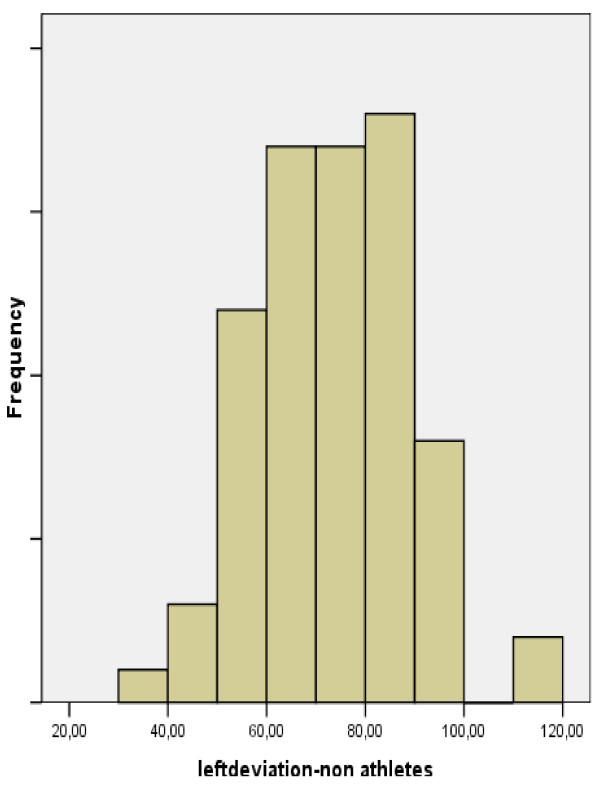
Graph depicting total deviation in the left hand of non-athletes.